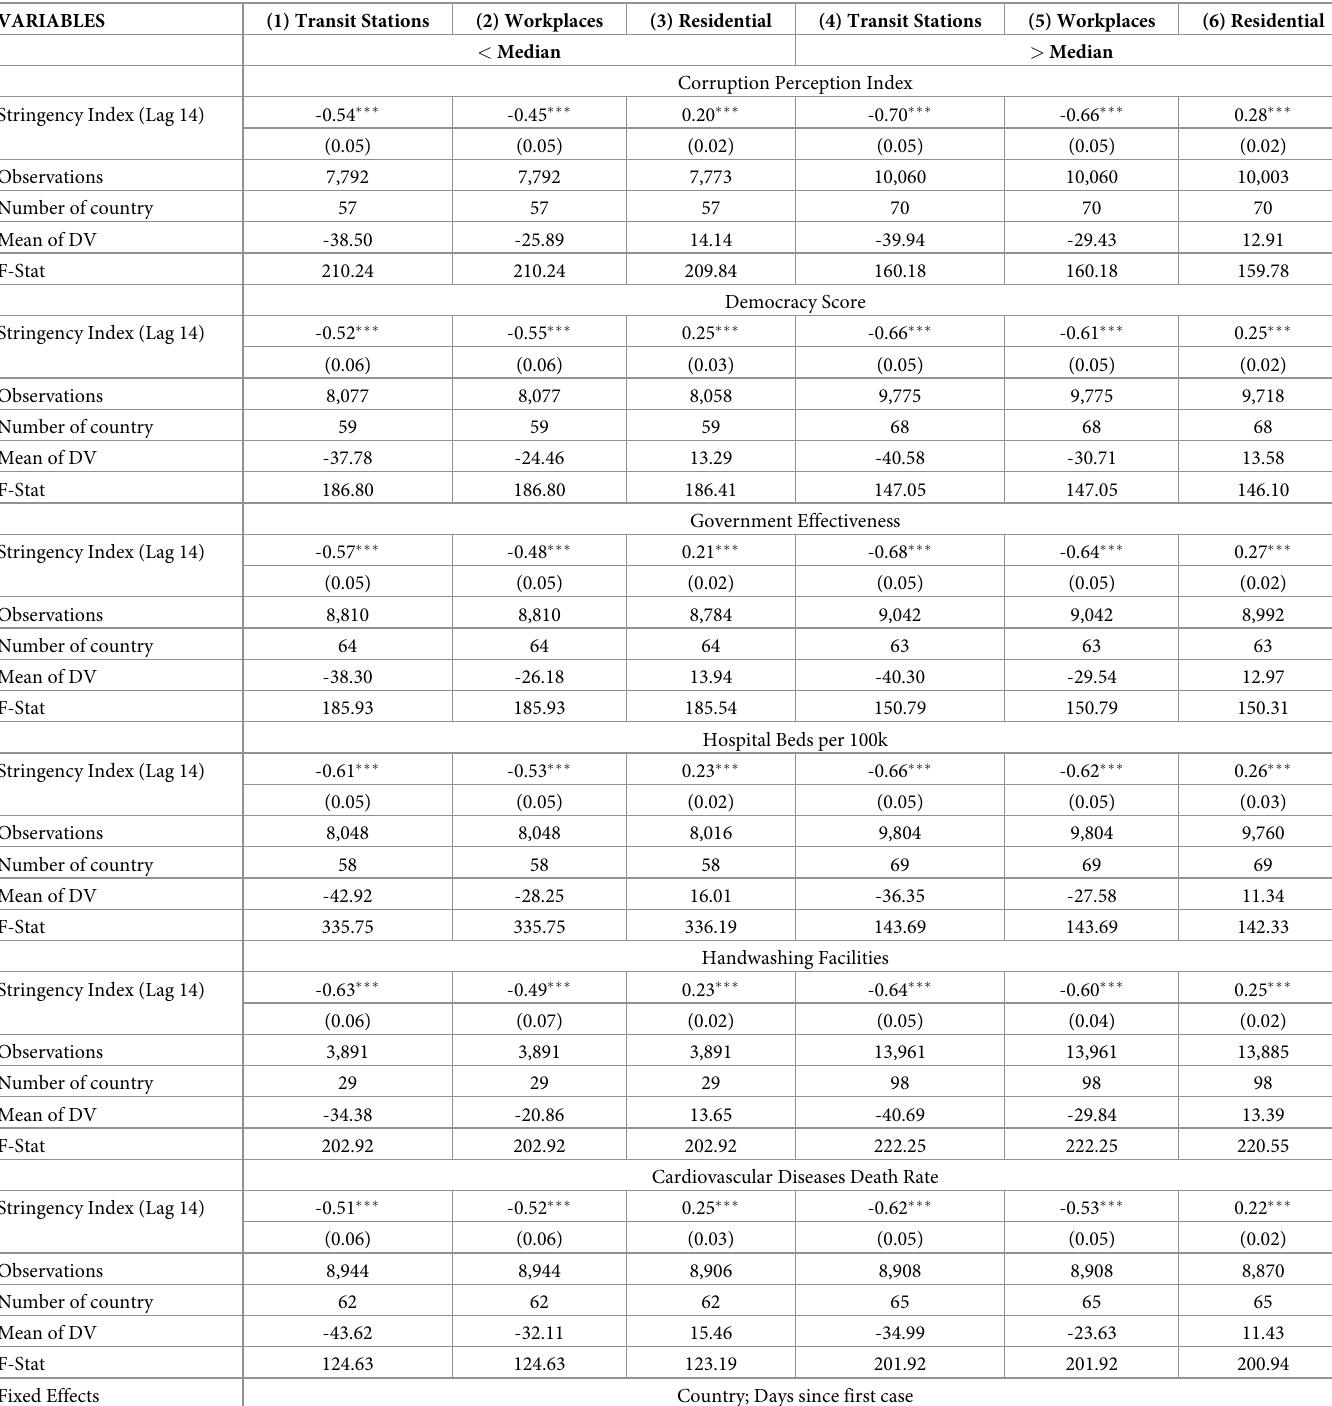
Table 5. Heterogenous impact of stricter restrictions on mobility